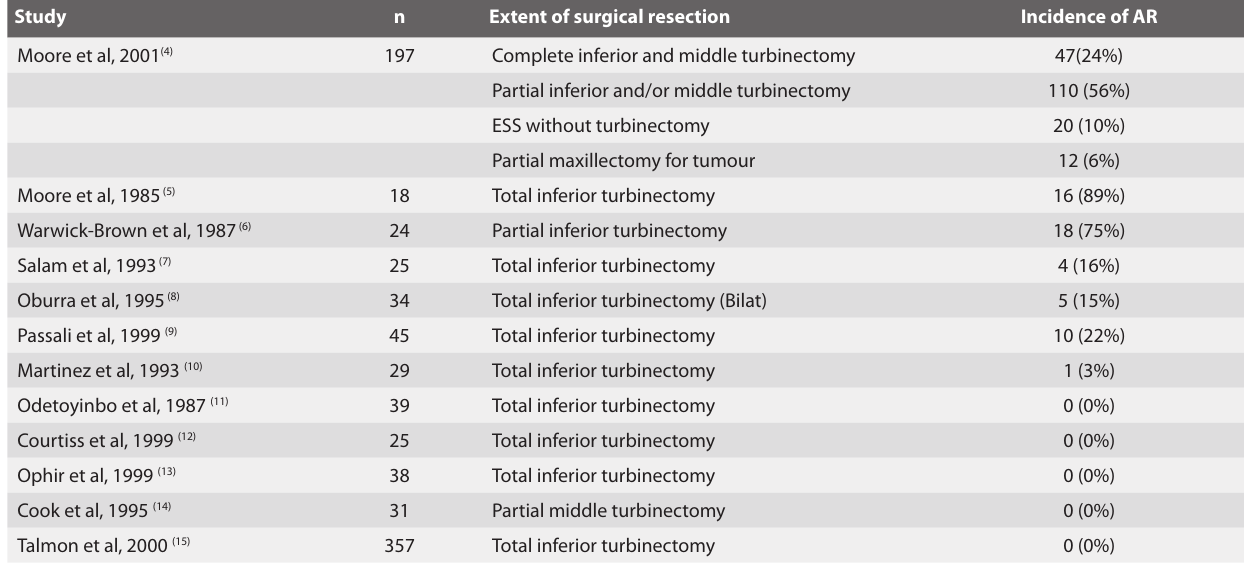
ESS=endoscopic sinus surgery.